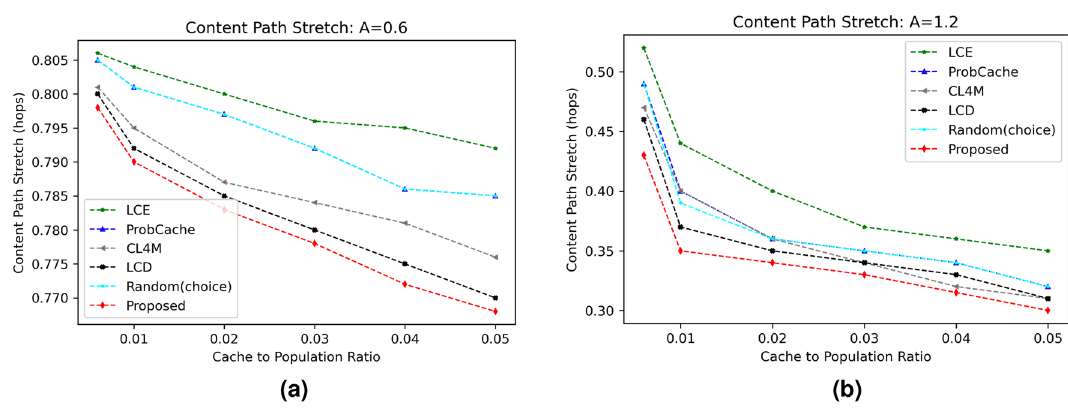
Figure 6. Influence of cache size on